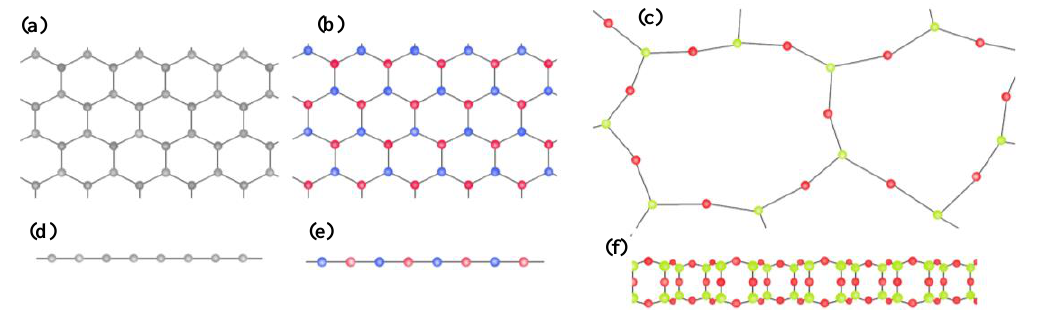
Figure 3. Comparison of graphene, boron nitride monolayer, and silica bilayer. Top view of ( a ) graphene, ( b ) boron nitride monolayer, and ( c ) silica bilayer. Side view of ( d ) graphene, ( e ) boron nitride monolayer, and ( f ) silica bilayer. Reproduced with permission from [124], Copyright American Chemical Society (ACS), 2016. It is worth noting that further permissions related to the material excerpted should be directed to the ACS.